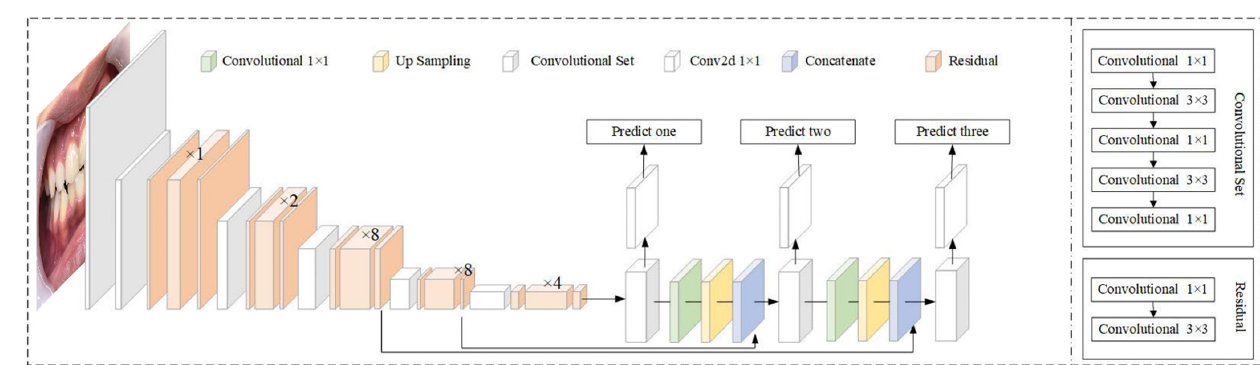
Figure 4. YOLOv3 architecture.